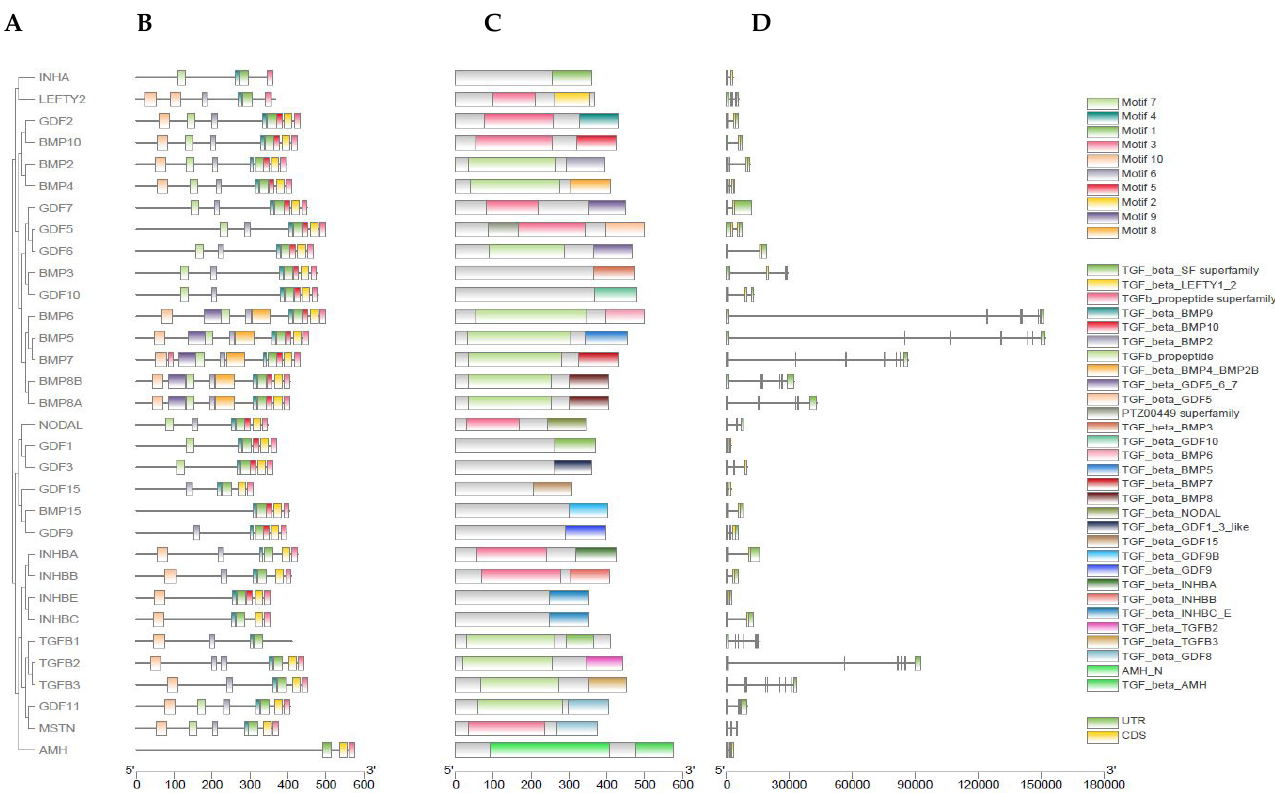
Figure 2. ( A ) Phylogenetic relationship of buffalo 32 TGF- β genes. ( B ) Motif patterns. ( C ) Conserved domain regions. ( D ) Gene structure.